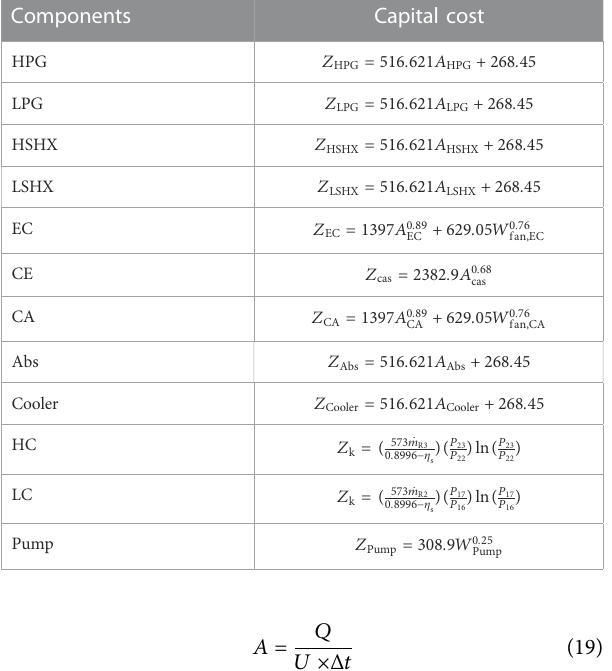
TABLE 4 Capital costs of the cascade refrigeration system. Components